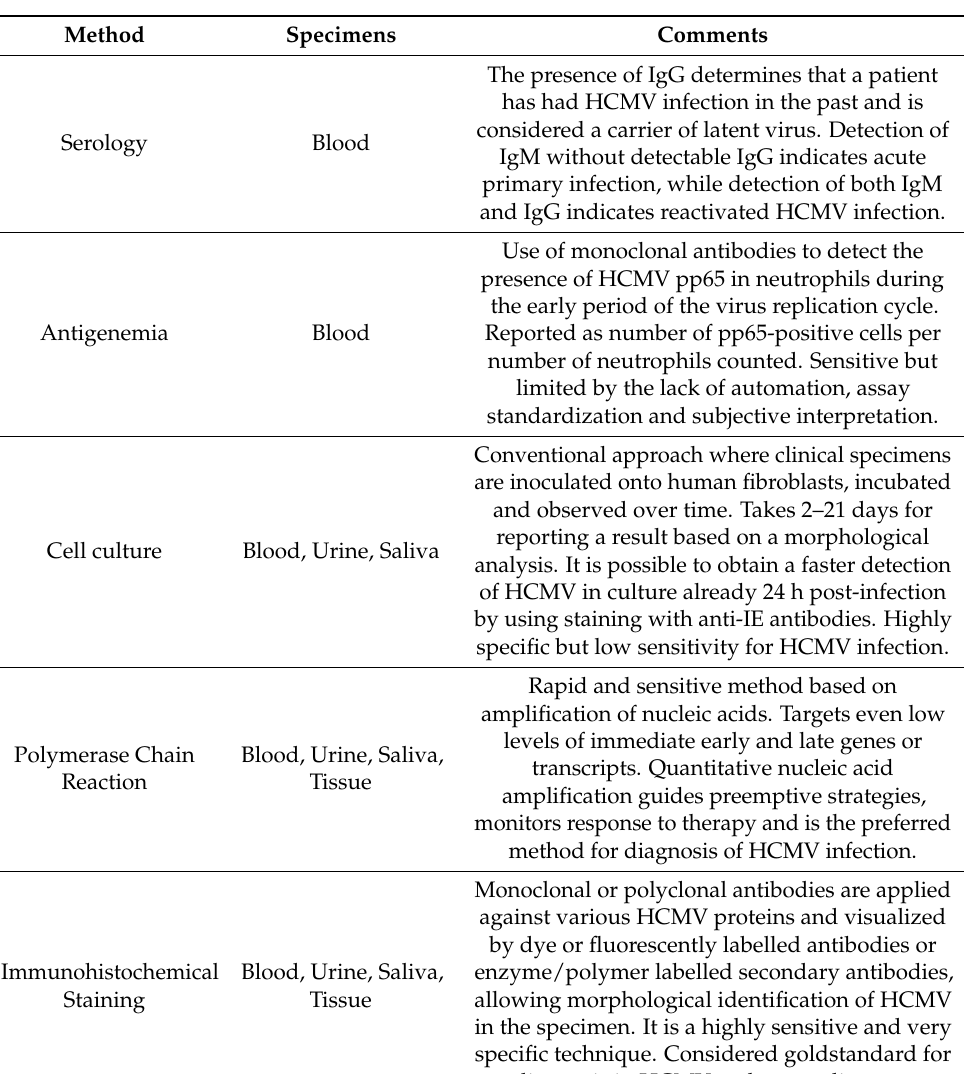
Table 1. Summary of conventional techniques used for detection of HCMV infection in different